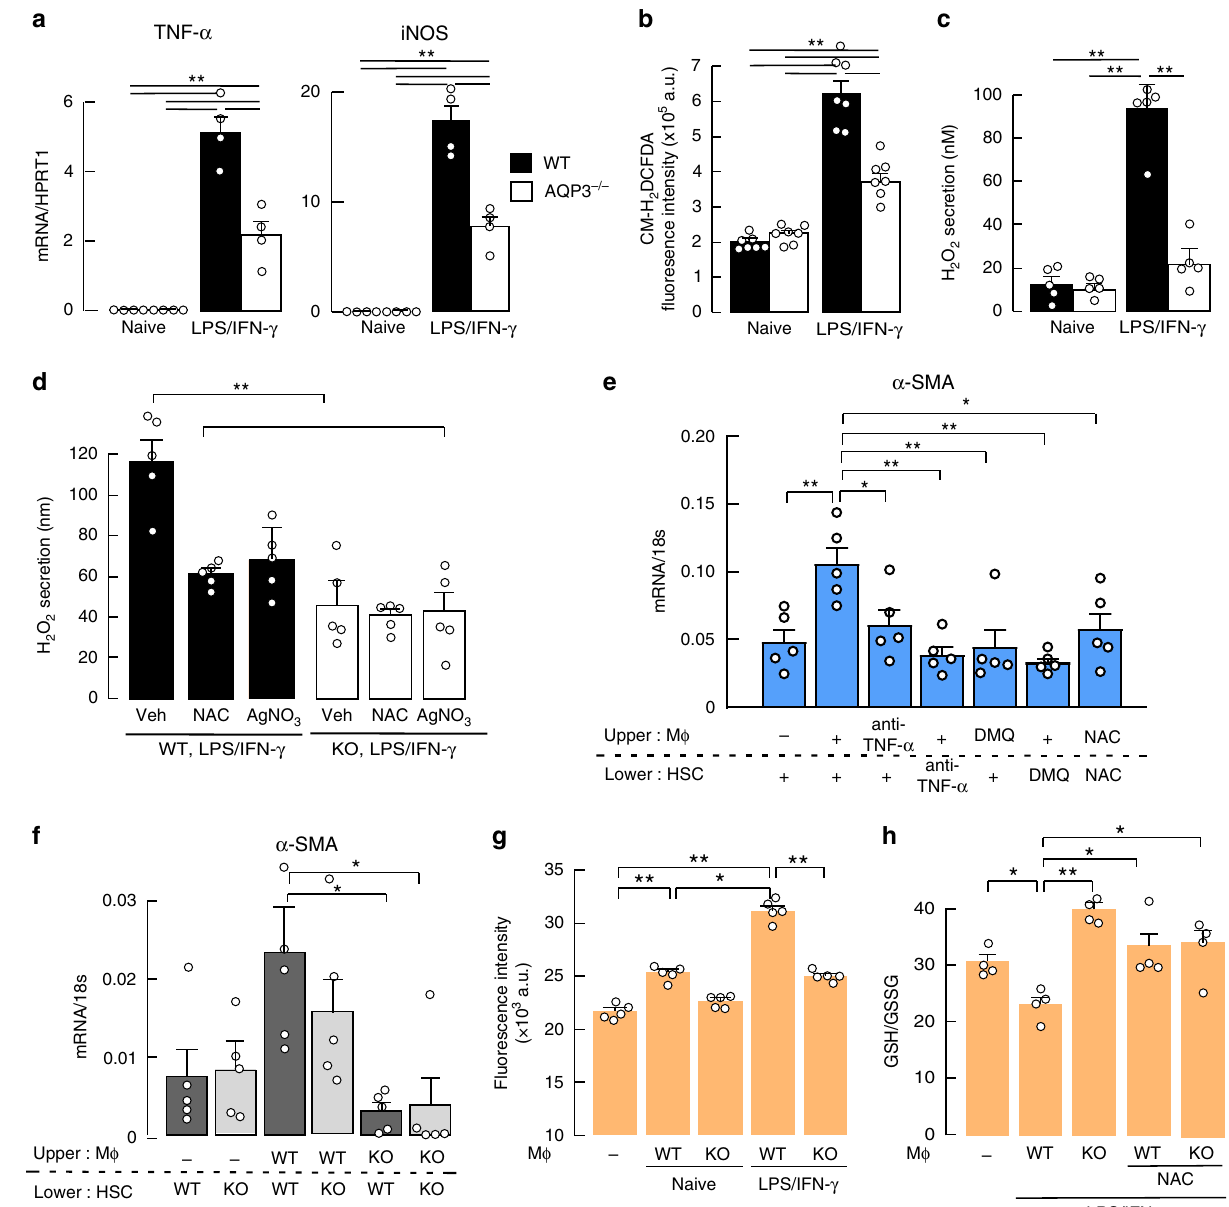
Fig. 3 Activated macrophages are involved in HSC activation and hepatocyte oxidative stress. a – d Naive bone marrow-derived macrophages from WT or AQP3 − / − mice were treated with LPS/IFN- γ (1 ng/ml; 10 ng/ml) for 24 h. a mRNA expression of TNF- α and iNOS. Data are expressed as the ratio to HPRT1 (mean ± SE, n = 4 biologically independent samples, ** p < 0.01). b Cellular ROS level (mean ± SE, n = 7 biologically independent samples, ** p